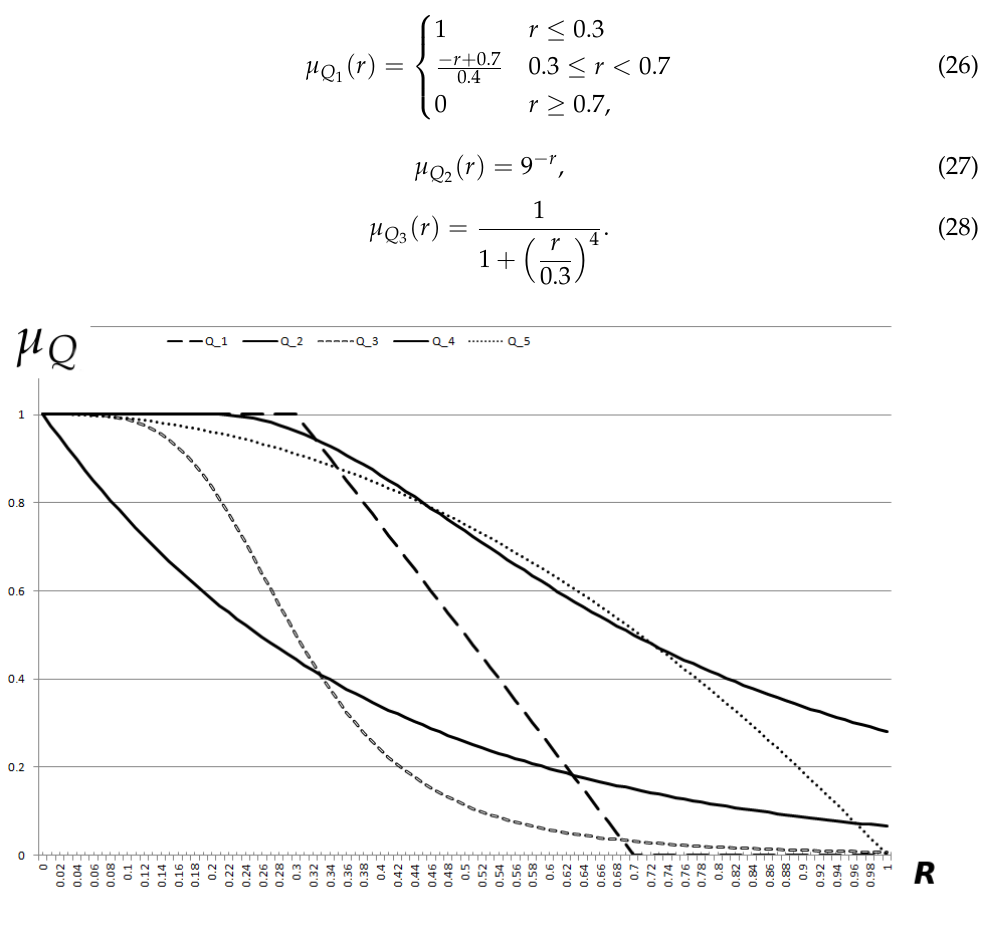
Figure 2. Membership functions of linguistic quantifiers Q 1 = “very few”, Q 2 = “close to 0”, Q 3 = “almost none”, i.e., (26)–(28), respectively, used in the linguistic summaries (see Table